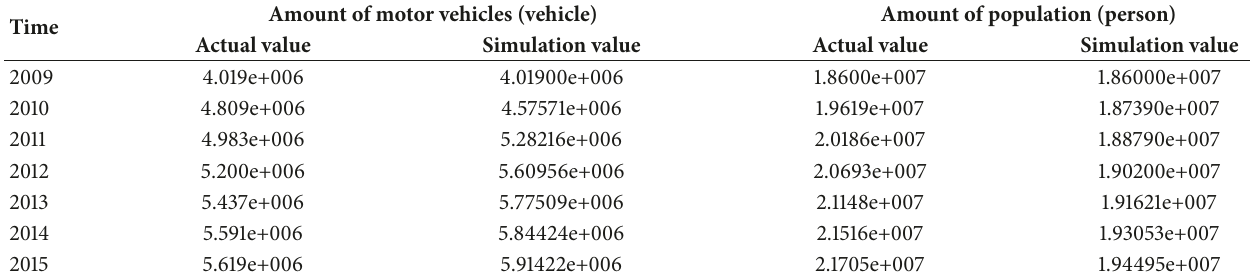
Table 9: Historical data and their simulation values